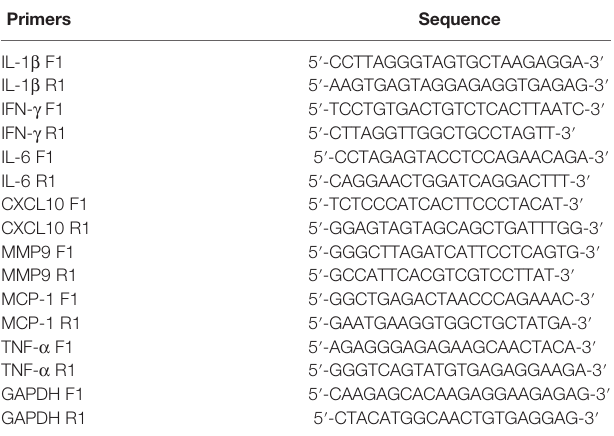
TABLE 1 | Primers used for polymerase chain reaction (PCR).